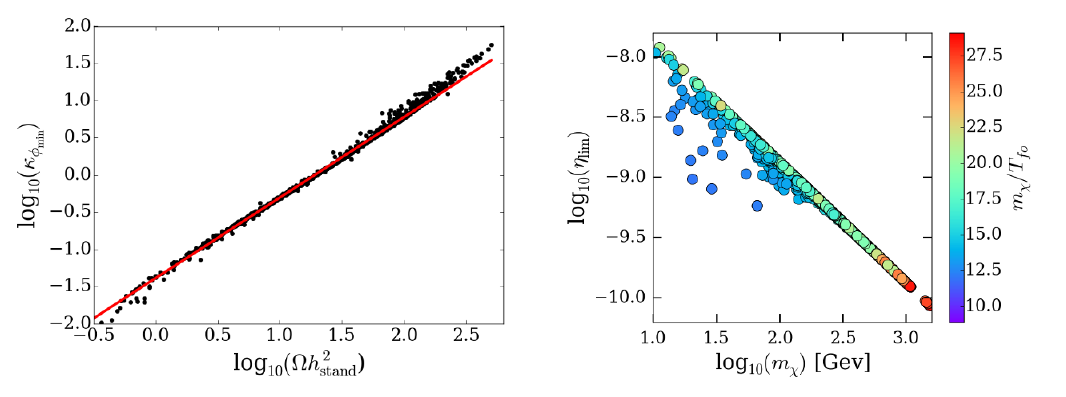
Figure 7. The values of (cid:20) (cid:30) required to re- Figure 8. The maximum value of the param- duce the relic density to the measured DM den- eter (cid:17) for the pMSSM19 sample of points as sity with T RH = T BBNlim and T init = 40 GeV a function of the neutralino mass. The values RH as a function of the relic density calculated in of m (cid:31) =T fo are colour-coded as indicated in the the standard model of cosmology. The calcula- tions were done for the sample of points in the pMSSM19 characterised in table 3.